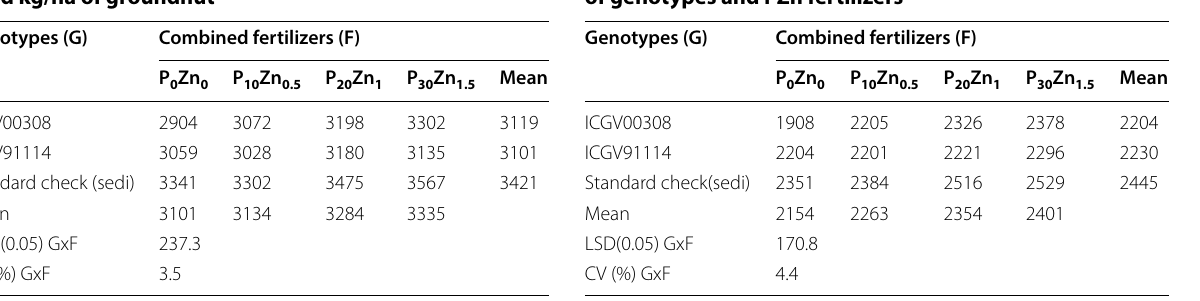
least significant difference at 5% level; =